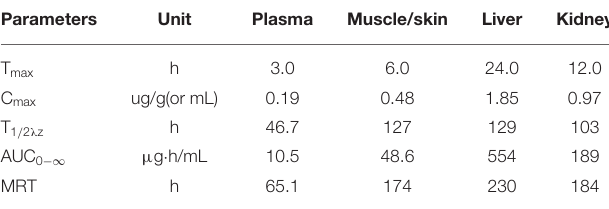
TABLE 2 | Pharmacokinetic parameters of ciprofloxacin in the plasma and tissues of crucian carp after oral administration of a single dose (20 mg/kg b.w.) of enrofloxacin at 28 ◦